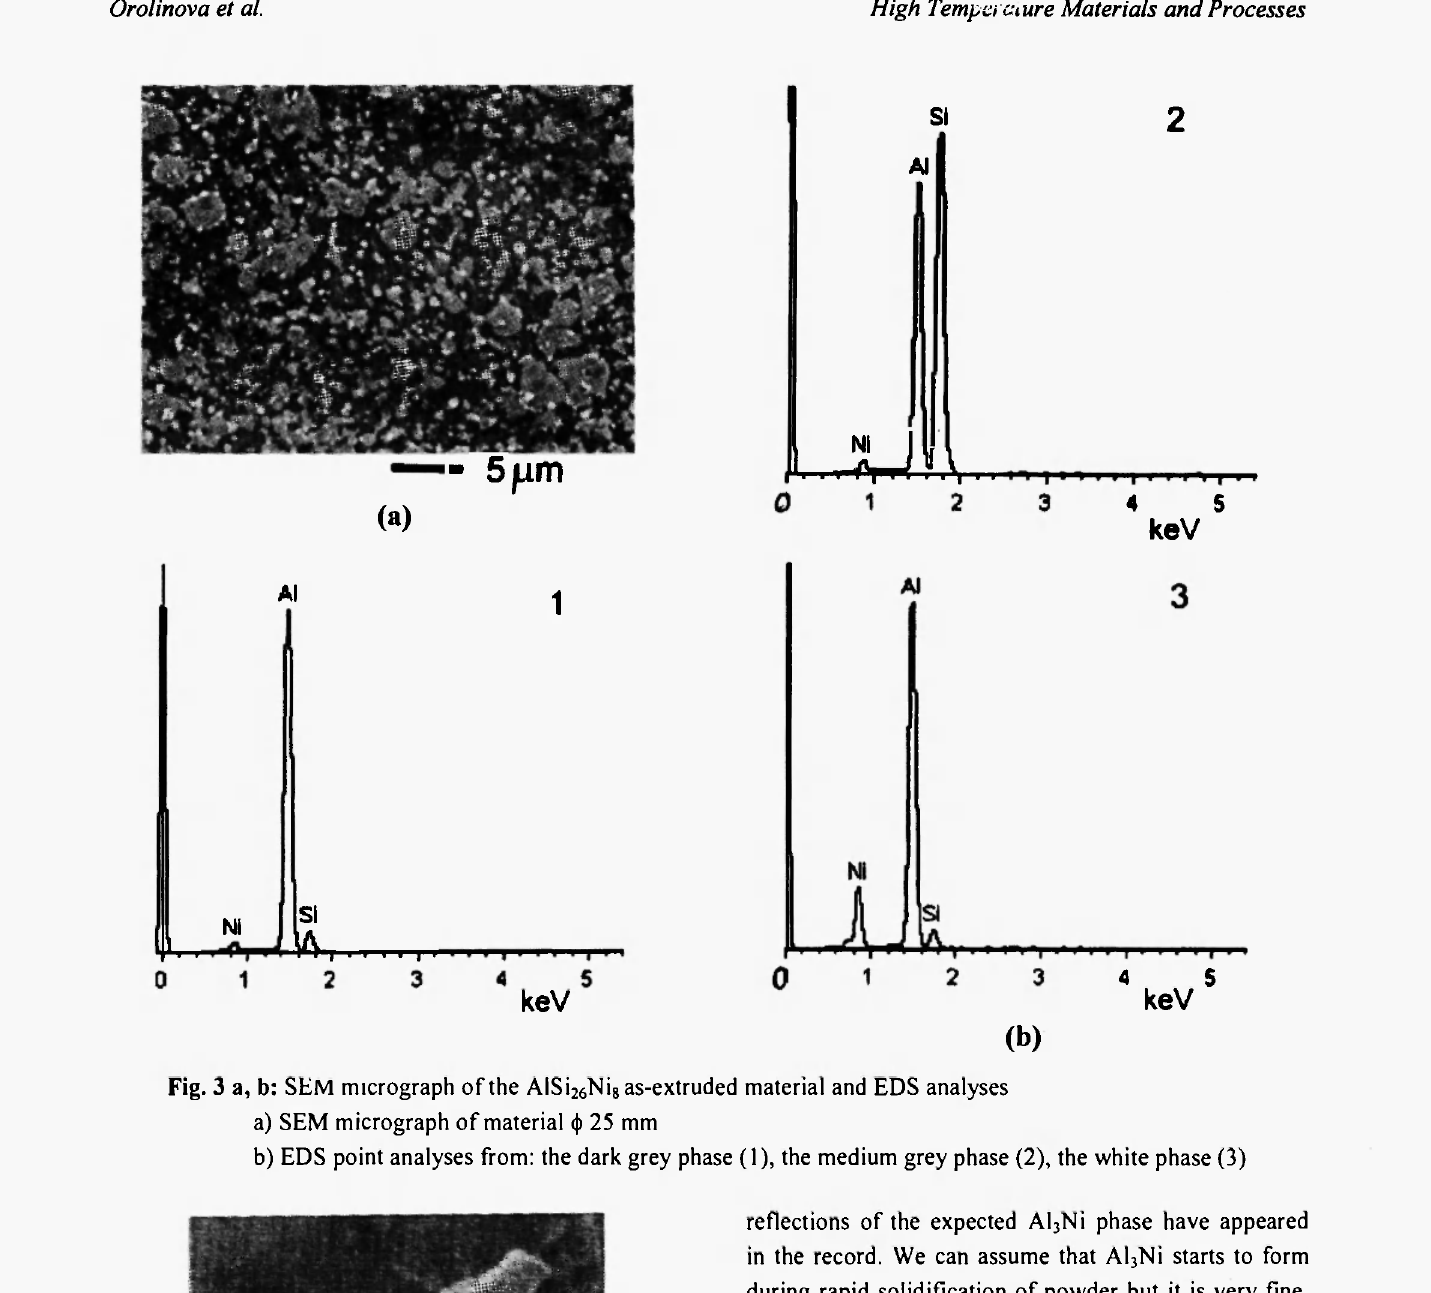
Fig. 3 a, b: SEM micrograph of the AISi 2 6Ni 8 as-extruded material and EDS analyses a) SEM micrograph of material φ 25 mm b) EDS point analyses from: the dark grey phase (1), the medium grey phase (2), the white phase